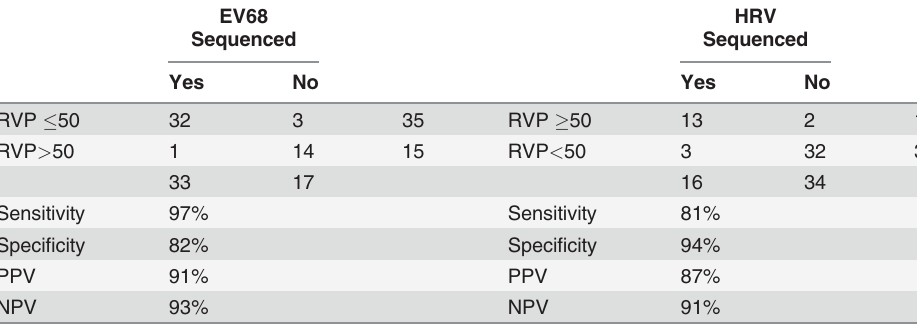
Table 3. Differentiating EV-D68 from HRV by RVP signal of 40Na.